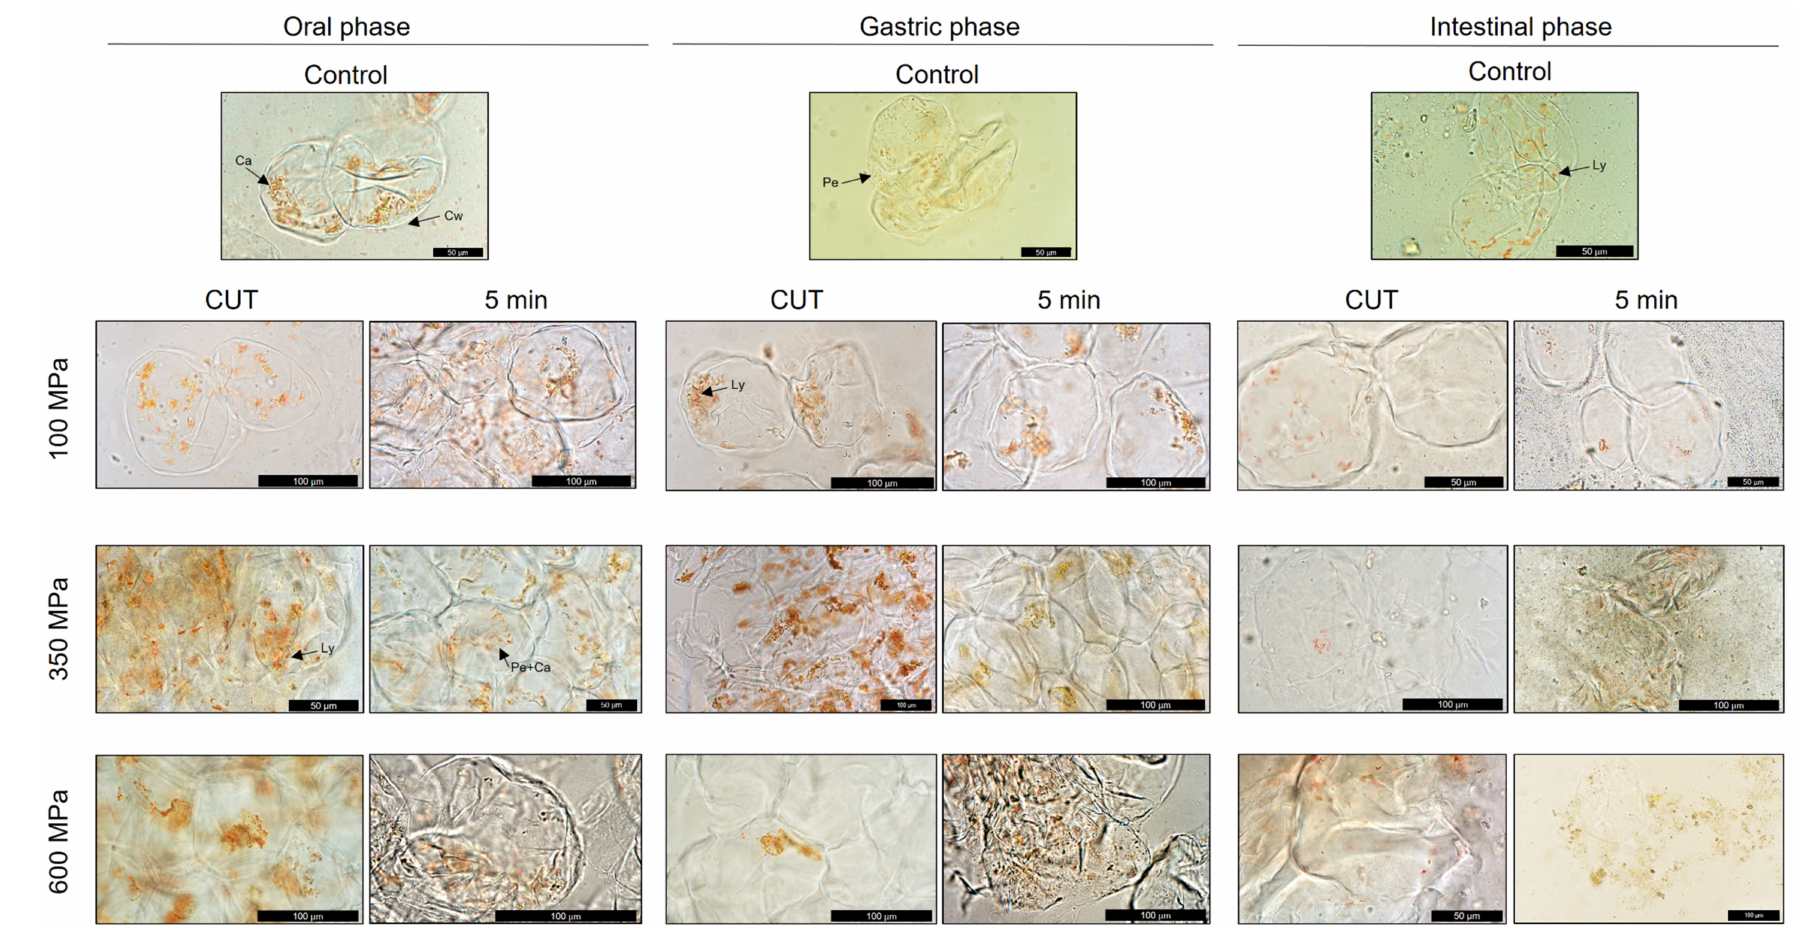
Figure 4. Optical microscopy of Sweet Mary papaya ( Carica papaya L.) variety of untreated pulps and submitted to HHP treatments of 100, 350 and 600 MPa at CUT and 5 min after in vitro simulated gastrointestinal digestion of digesta fractions. Ca, carotenoids; Cw, cell wall; Ly, lycopene crystalloid formation; Pe, pectin; Pe+Ca, carotenoids surrounded by